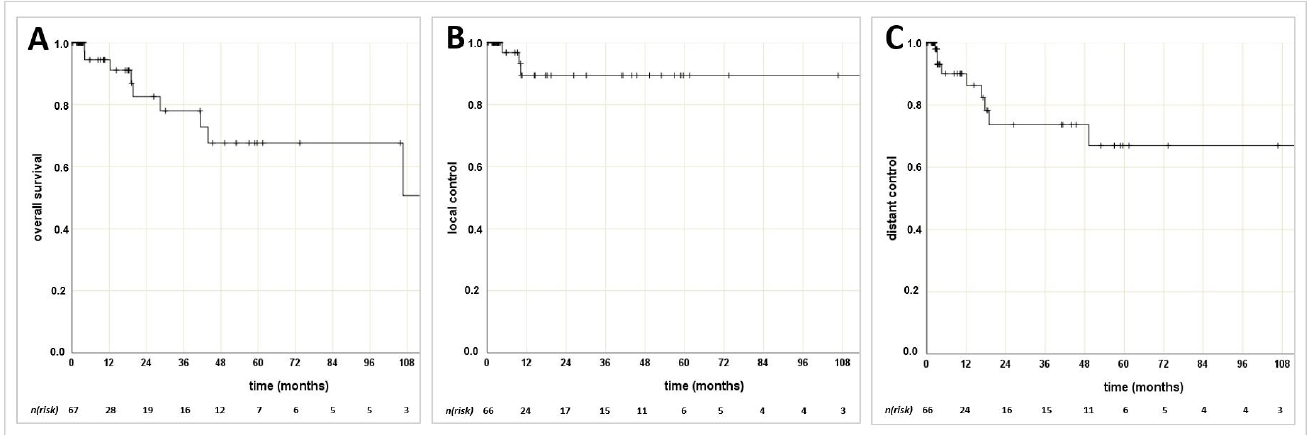
Figure 1. Kaplan–Meier curves for ( A ) overall survival, ( B ) local control, ( C ) distant control, n ( risk ): number at risk. Table 4. Univariate analyses.